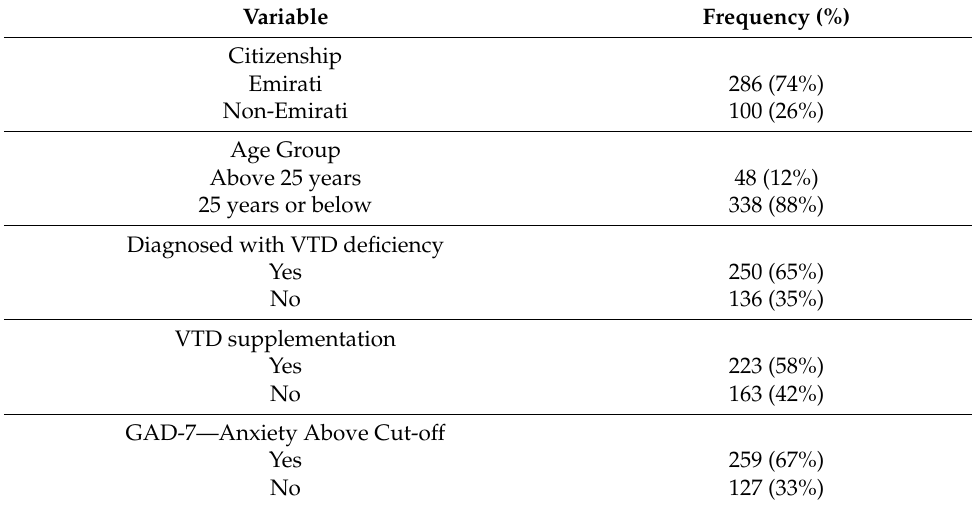
Table 1. Sample characteristics of the study